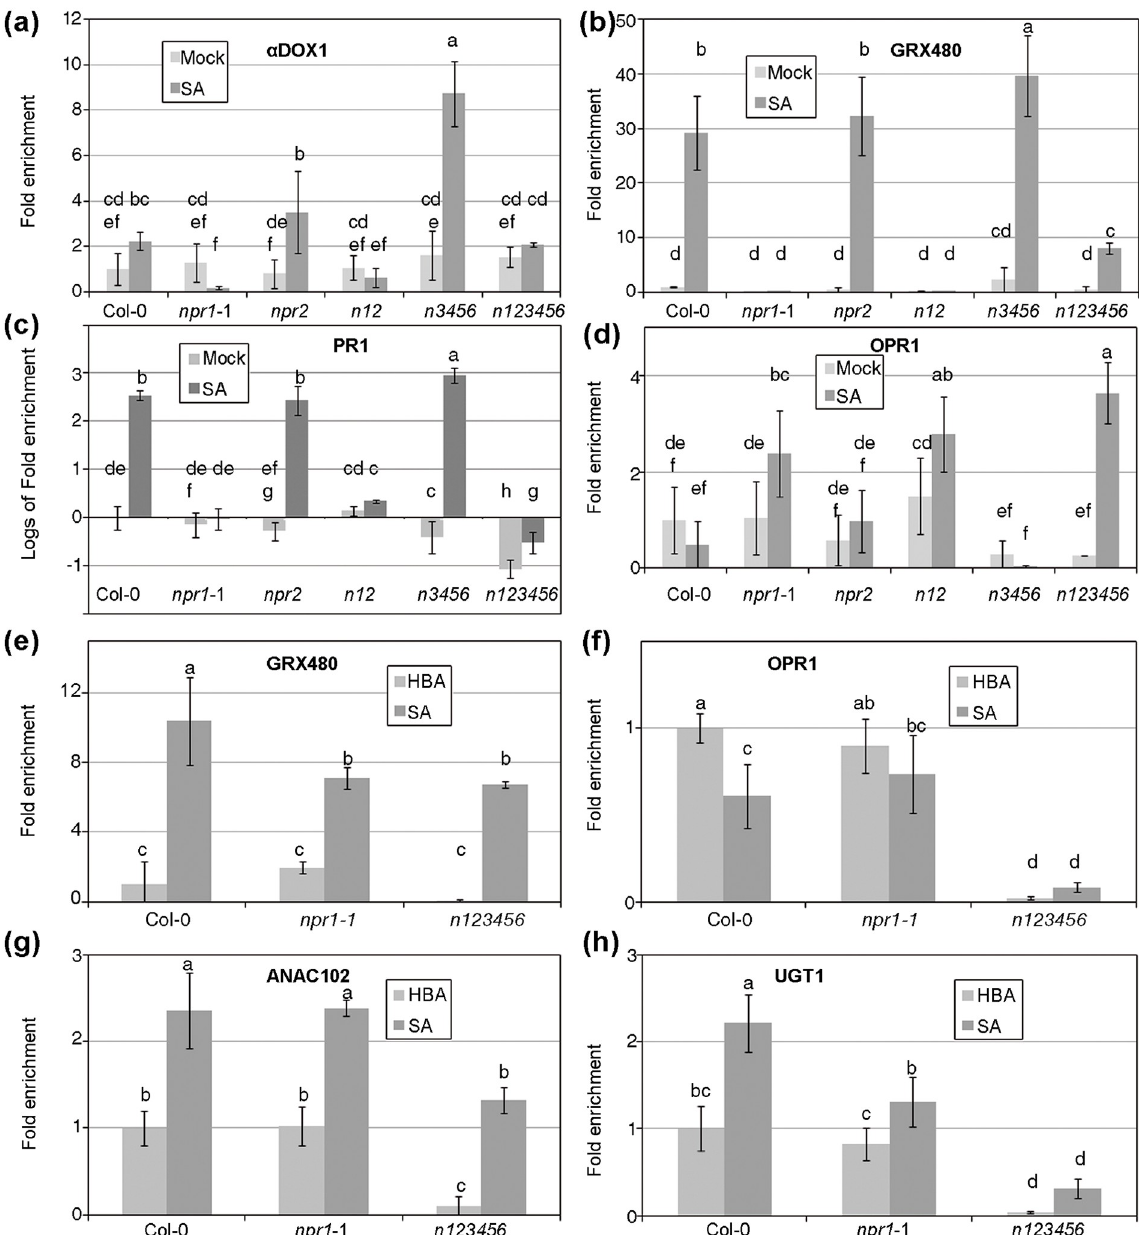
Fig 3. Gene expression depending on NPR1 paralogs. RNA was extracted from two week old plants of the indicated genotypes. In the (a) to (d) panels, the samples were taken one day after treatments of mock or 1 mM SA, while in the (e) to (h) panels, the samples were taken 2.5 h after treatment of 1 mM 4-hydroxybenzoic (HBA, a isomer of SA with no biological activity) or 1 mM SA. (a) Fold enrichment of α -Dioxygenase 1 , one day after treatment. (b) Fold enrichment of Glutaredoxin 480 , one day after treatment. (c) Fold enrichment of PR1 one day after treatment, in logarithmic scale. (d) Fold enrichment of 12-Oxophytodienoate reductase 11 , one day after treatment. (e) Fold enrichment of Glutaredoxin 480 , 2.5 h after treatment. (f) Fold enrichment of 12-Oxophytodienoate reductase 11 , 2.5 h after treatment. (g) Fold enrichment of NAC domain containing protein 102 , 2.5 h after treatment. (h) Fold enrichment of UDP-glucose transferase 1 , 2.5 h after treatment. The transcript levels of the indicated genes were measured by RT-qPCR, and the levels of expression are normalized to three reference genes and to the level of Col-0 in mock or HBA